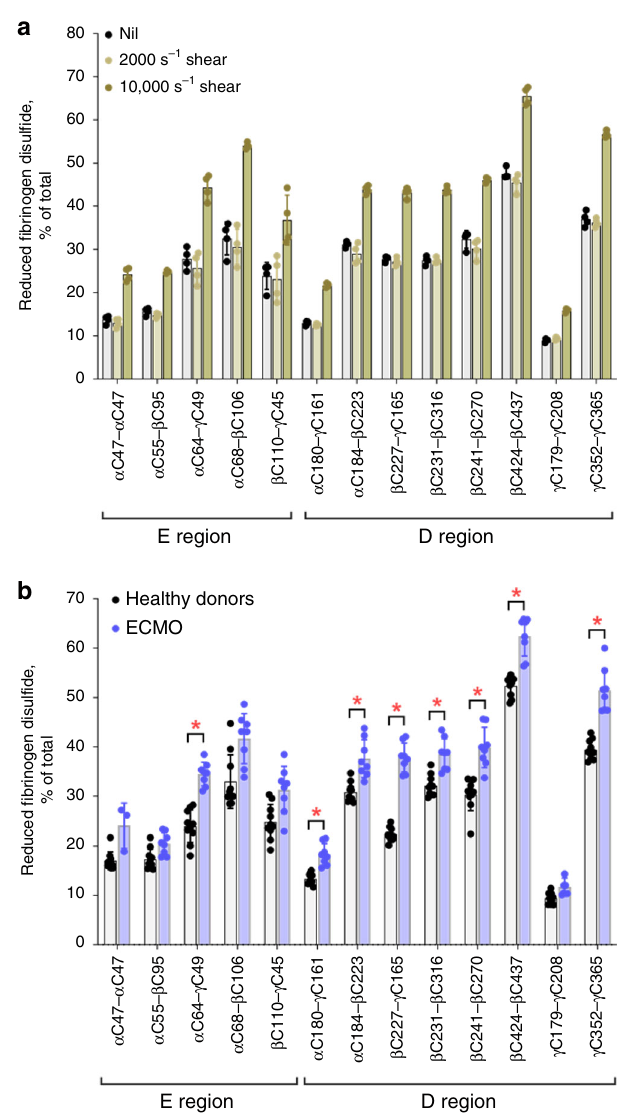
Fig. 5 Fibrinogen covalent states are changed by mechanical shearing in vitro and in heart failure patients subjected to ECMO. a Redox states of the fi ve E region and eight D region fi brinogen disul fi des of four different healthy donor plasmas sheared at rates of 2000 s − 1 or 10000 s − 1 for 5 min. The bars and errors are mean ± SD. Shearing at 10000 s − 1 results in reduction of all 13 fi brinogen disul fi des ( p < 0.01 for the β C110- γ C45 bond and p < 0.001 for the other disul fi des). Parametric unpaired t -test was used to evaluate differences between groups. Source data are provided as a Source Data fi le. b Redox states of the fi ve E region and eight D region fi brinogen disul fi des in healthy donors ( n = 10) versus patients with severe congestive cardiac failure subjected to ECMO ( n = 8). The bars and errors are mean ± SD. Signi fi cant differences ( p < 0.001) in the redox state of fi brinogen disul fi des are indicated by stars. Parametric unpaired t -test was used to evaluate differences between groups. Source data are provided as a Source Data fi